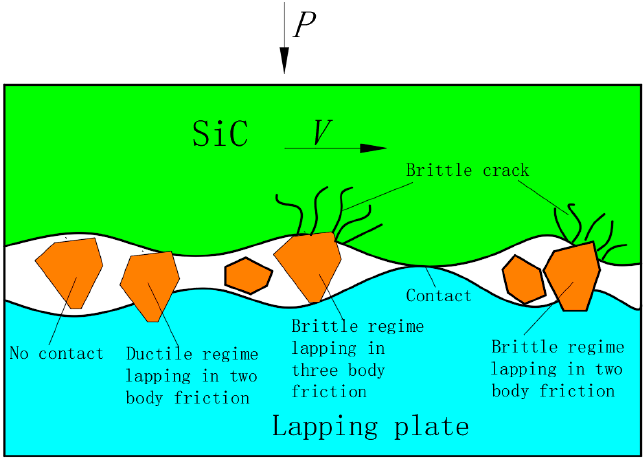
Figure 8. Three-Body and two-body abrasion.